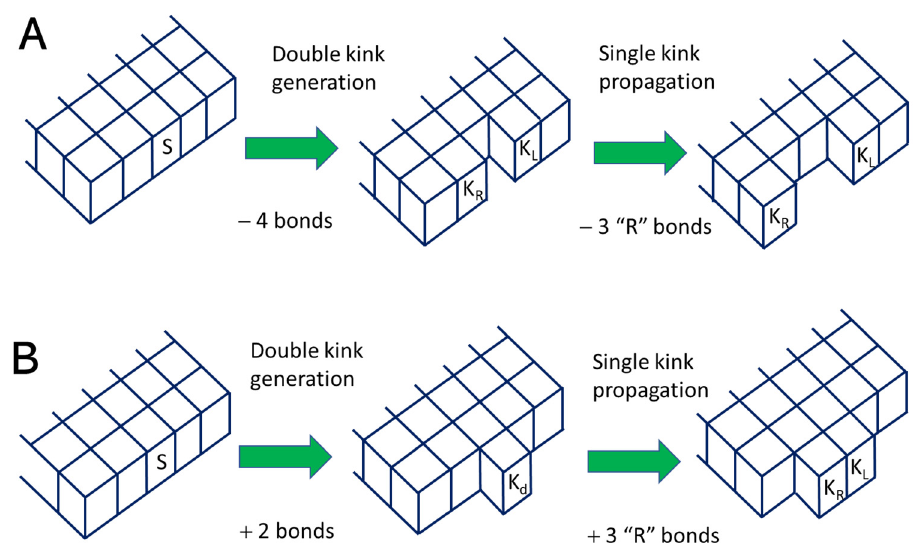
Figure 1. A schematic drawing for elementary processes on crystalline surface, Kossel crystal model, first introduced in [29,30]. ( A ): Atomic step retreat during crystal dissolution; ( B ) Atomic step advancement during crystal growth. The letters “R” and “L” denote right and left kinks, that may have non-equivalent propagation rates in non-Kossel structures.